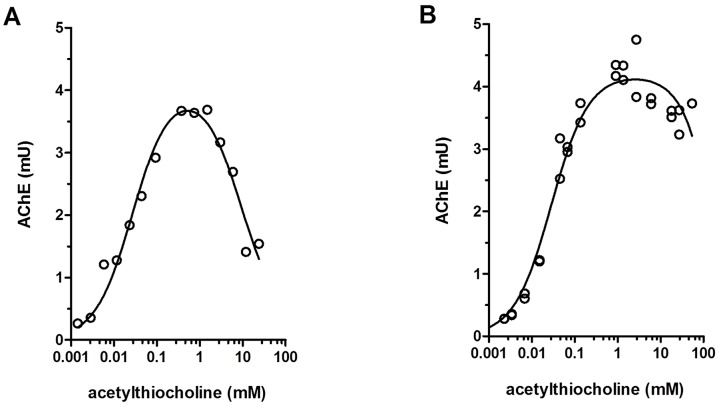
Substrate inhibition of brain AChE from mullet (Mugil liza) (A) and hen (Gallus) (B).Each point represents an AChE assay for enzymes pooled from three different animals. Curves were fitted as proposed by Radic et al. [22] for the inhibition of AChE by excessive substrate: R2 = 0.9618 for mullet enzyme; R2 = 0.9699 for the chicken enzyme.